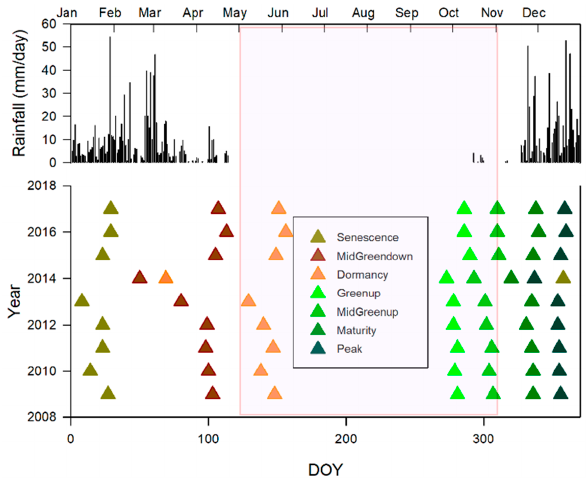
Figure 2. Phenology calendar at the Miombo Woodland site in Mpika, Zambia based on the data for the period 2009 to 2017. Shaded box indicates the dry season.